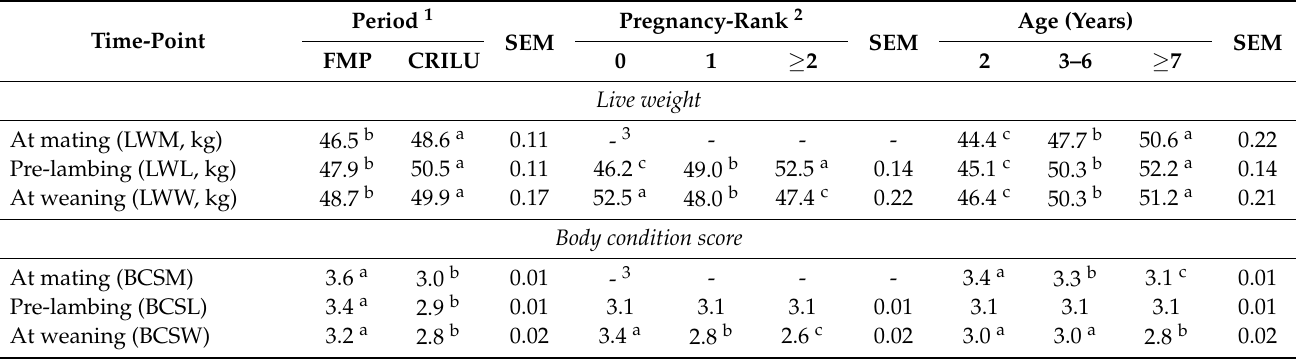
Table 4. Least square means (LSMs) and standard errors of the mean (SEMs) of the live weight at mating (LWM, kg), pre-lambing (LWL, kg), and at weaning (LWW, kg) and the body condition score at mating (BSCM), pre-lambing (BCSL), and at weaning (BCSW) by the period, pregnancy-rank, and age group